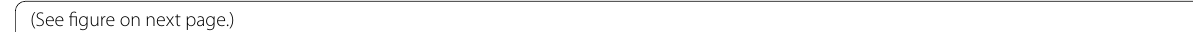
Fig. 4 NMDS of plant functional groups ( A ), ant traits ( B ), and ant functional groups ( C ). Convex hulls and centroids of the distribution of grouped data Labels codes (centred on scores): A Grass_G: Grasses Geophytes; Grass_H: Grasses Hemicryptophytes; Grass_T: Grasses Therophyte; Gymno_P: Gymnosperm Phanerophytes; Legume_CH: Legumes Chamaephyte; Legume_H: Legumes Hemicryptophyte; Legume_P: Legumes Phanerophyte; Legume_T: Legumes Therophyte; Oth.dycot_CH: Other Dicotyledons Chamaephyte; Oth.dycot_G: Other Dicotyledons Geophyte; Oth.dycot_H: Other Dicotyledons Hemicryptophyte; Oth.dycot_NP: Other Dicotyledons Nanophanerophyte; Oth.dycot_P: Other Dicotyledons Phanerophyte; Oth.dycot_T: Other Dicotyledons Therophyte; Oth.monocot_G: Other Monocotyledons Geophyte; Oth.monocot_H: Other Monocotyledons Hemicryptophyte; Oth.monocot_T: Other Monocotyledons Therophyte; Pterid_CH: Pteridophytes Chamaephyte; Pterid_G: Pteridophytes Geophyte; Pterid_H: Pteridophytes Hemicryptophyte; Sedge_G: Sedges Geophyte; Sedge_H: Sedges Hemicryptophyte. B D: diurnal; nD: not strictly